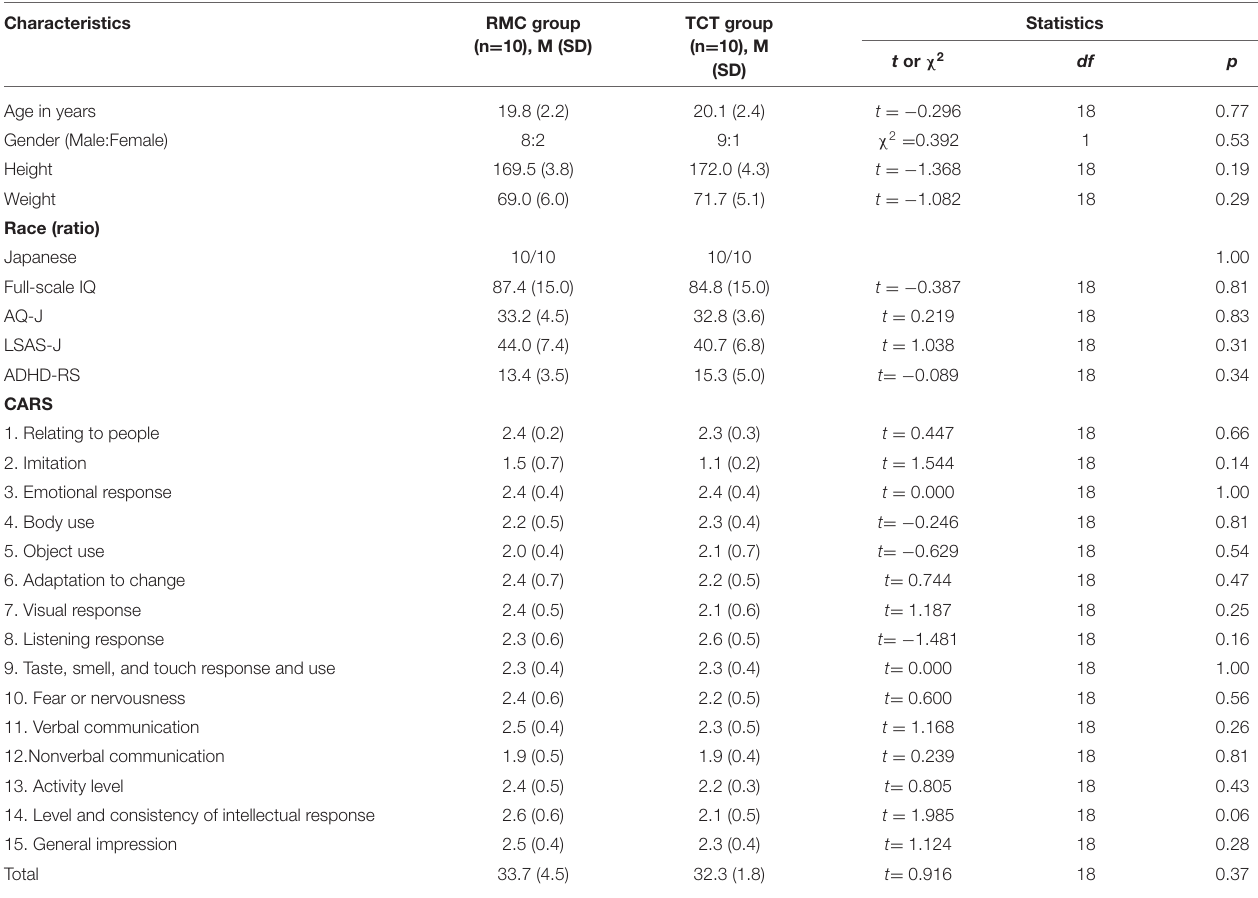
TABLE 1 | Descriptive Statistics of Participants in the RMC group and TCT